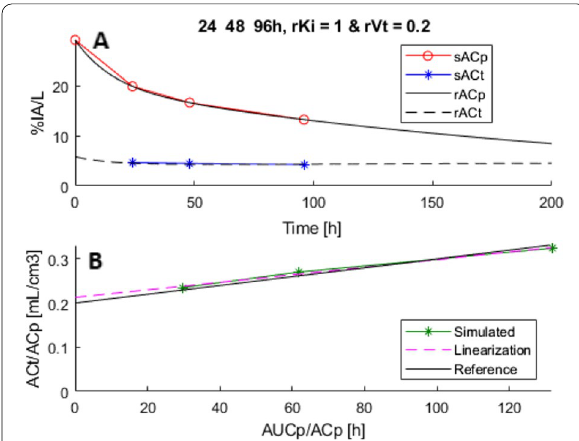
Fig. 2 Patlak linearization for 89 Zr‑pertuzumab input function and time activity curves with 5% noise, rK i 1 10 − 3 [h − 1 ], rV T 0.2 and = · = time points 24, 48 and 96 h post‑injection. A : Activity concentrations in plasma (red) and tissue (blue), full curve based on reference values (rAC p and rAC t ) and calculated based on simulations (sAC p and sAC t ) in percentage injected activity per liter as a function of time p.i. B : Patlak plot; activity concentration in tissue (AC t ) divided by activity concentration in plasma (AC p ) as a function of area under the plasma curve (AUC p ) divided by activity concentration in plasma (AC p ). Based on reference values (black), simulated values (green) and linear regression of the simulated values (pink). %IA/L percentage = injected activity per